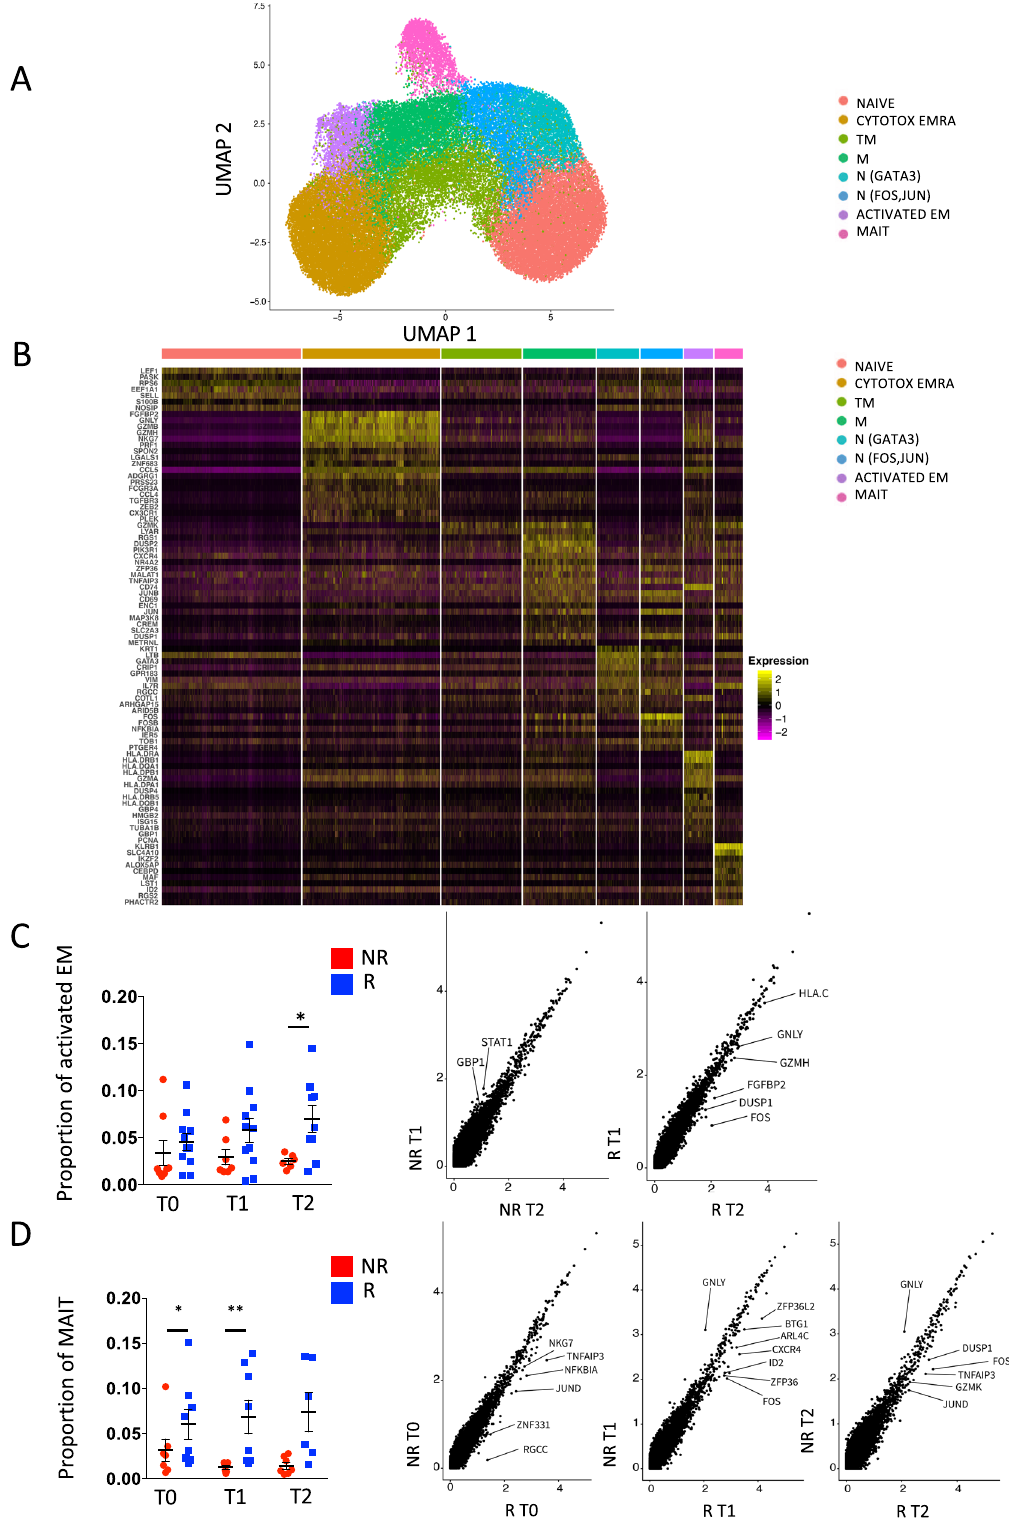
Pseudotime analysis revealed that the differentiation process started from naive T cells towards terminally differentiated T cells passing through activated naive T cells, transitional effector memory T cells and effector memory T cells (Supplementary Fig. 4). In this process, the transcriptionally distinct MAIT cells belong to a different branch of the Pseudotime